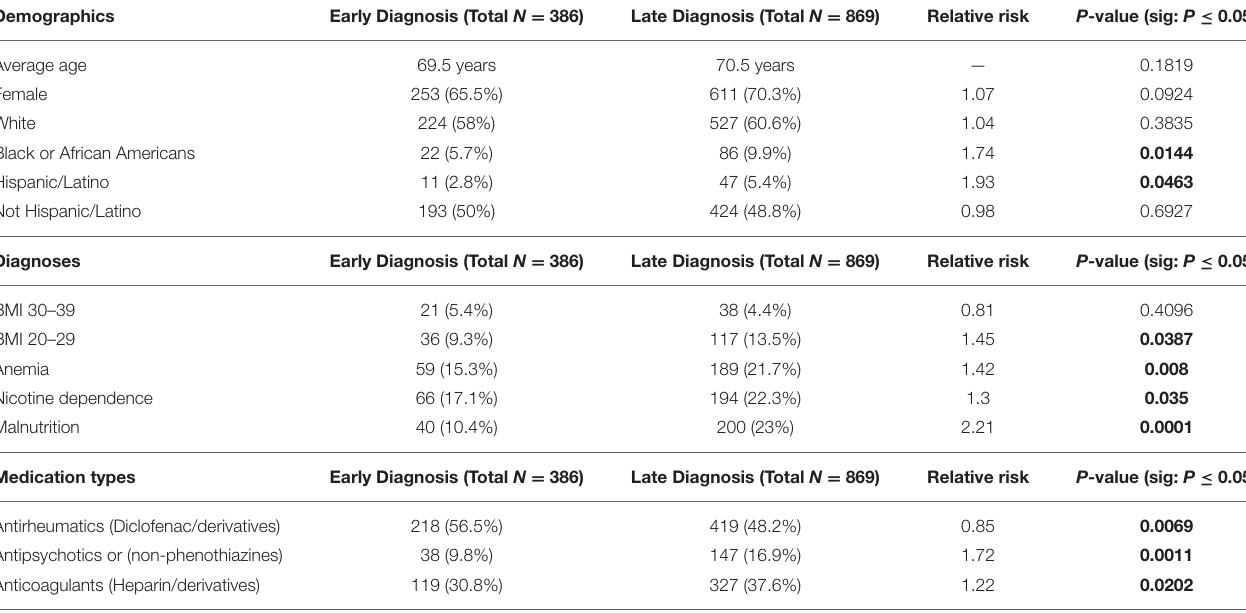
TABLE 1 | Early and late diagnosis of oral cancer by patient